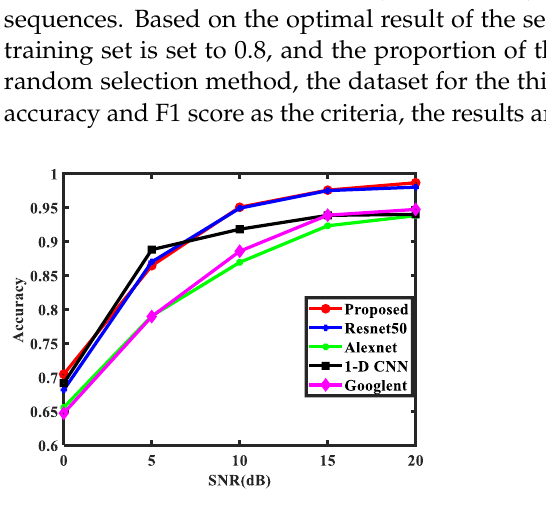
Figure 9. The performance with different proportions of the training set.